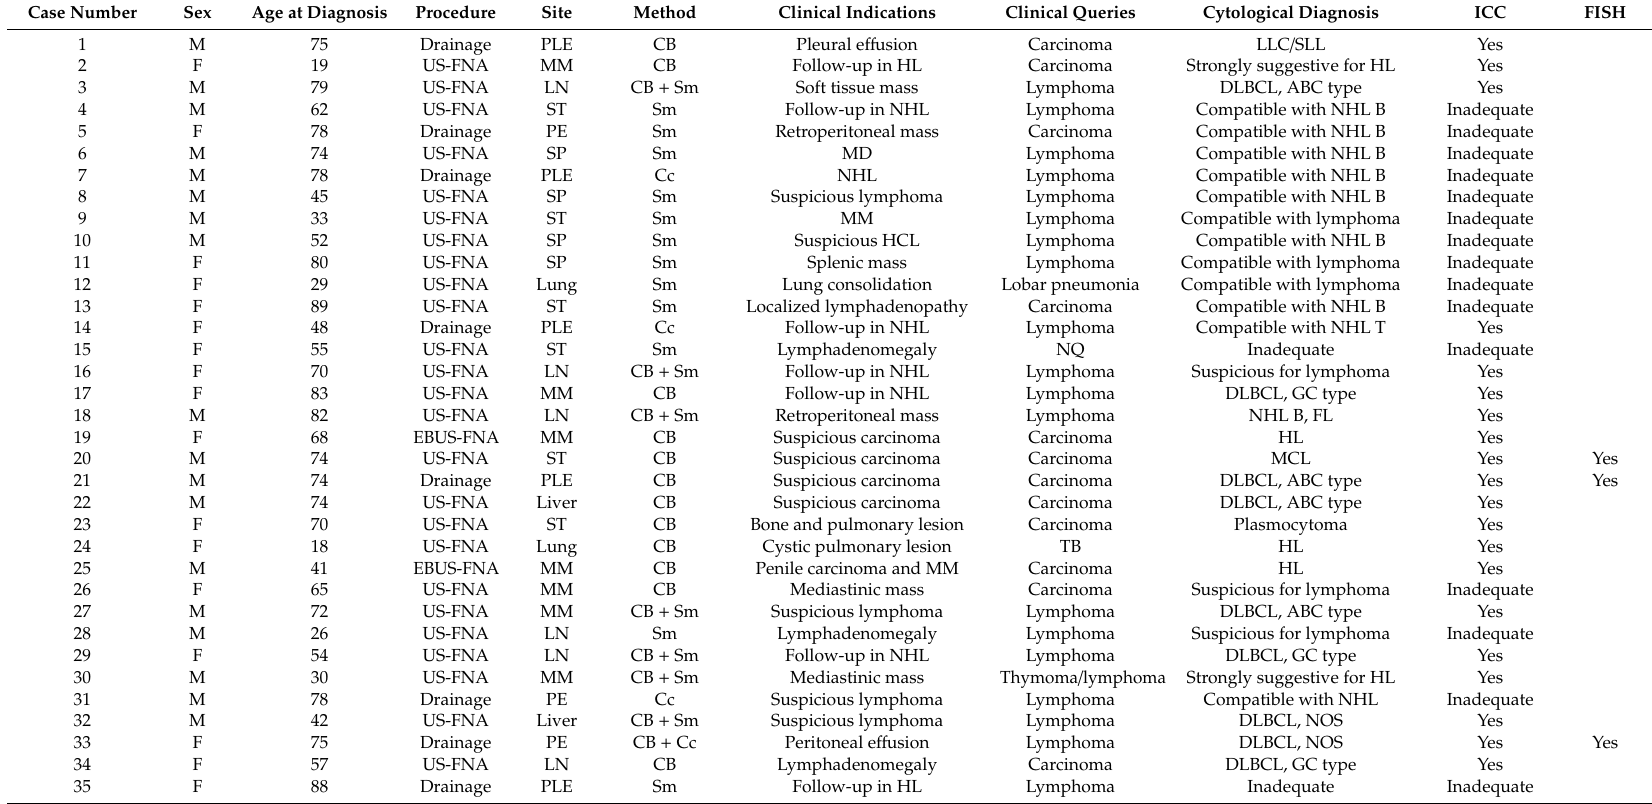
Table 1. Patient demographics, clinical findings, procedure details and diagnosis. CB: cell block; Cc: Cytocentrifugate; CLL / SLL: Chronic Lymphocytic Leukemia / Small Lymphocytic lymphoma; DLBCL, ABC-type: Di ff use Large B-cell lymphoma, Activated B-cell type; DLBCL, GCB type: Di ff use Large B-cell lymphoma, Germinal Center type; DLBCL, NOS: Di ff use Large B-cell lymphoma Not Otherwise Specified; EBUS-FNA: Endobronchial Ultrasound-guided Fine Needle Aspiration; FISH: Fluorescence In Situ Hybridization; FL: Follicular lymphoma; HCL: Hairy Cell Leukemia; HL: Hodgkin lymphoma; ICC: Immunocytochemistry; LN: Lymph-node; MCL: Mantle Cell lymphoma; MM: Mediastinum Mass; NHL: non-Hodgkin lymphoma; PLE: Pleura; Sm: Smear; SP: Spleen; ST: Soft Tissue; TB: Tubercolosis ; US-FNA: Ultrasound-guided Fine Needle